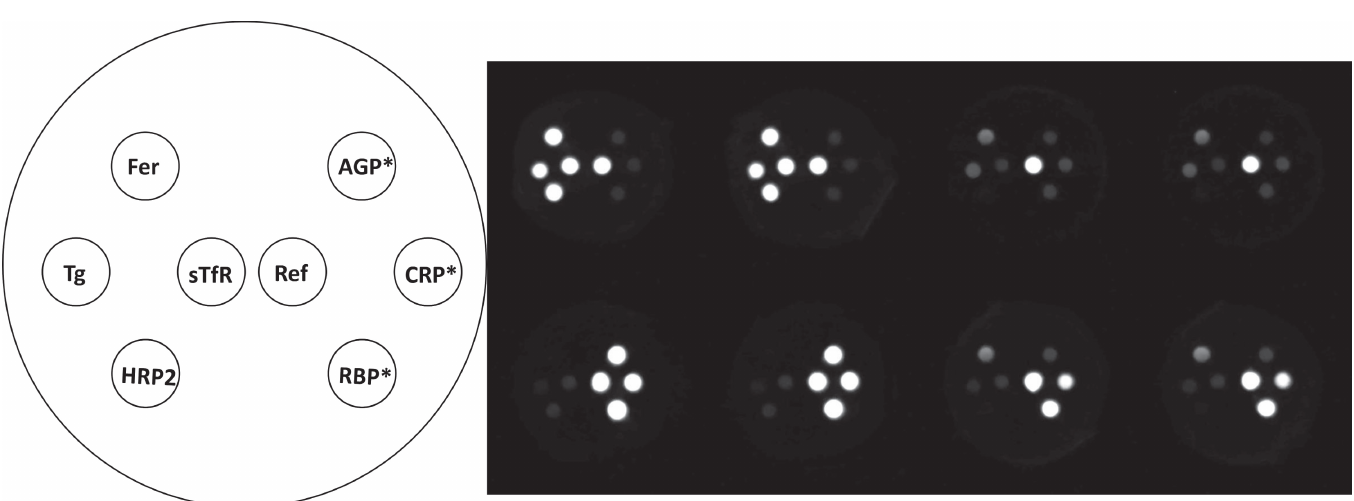
Fig 1. The orientation of assaysand a referencespot on the 7-Plex planar array displayed in each well of a 96-well plate. The image on the right is an exampleof test wells and the levels of chemiluminescence of each test spot on the 7-Plex array when challenged with different levels of analyte: 8 wells with 4 duplicatesamples screenedusing a high calibrator(top left) where the sandwichassay spots give a bright signal and the competitive assay spots are muted, negativecontrols (bottom left) where the competitiveassays have a strong signal whilst the sandwich assays are faint, and two samples(top and bottom right). The reference spot in each well remainsat a similar intensity across all wells shown. AGP, α -1-acidglycoprotein; CRP, C-reactiveprotein; Fer, ferritin; HRP2, histidinerich protein II; Ref, referencespot; RBP, retinol bindingprotein 4; sTfR, solubletransferrin receptor; Tg, thyroglobulin. a Indicates a competitive ELISA format, other assays are in a